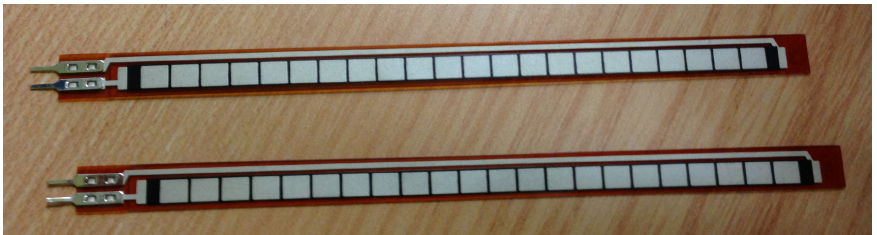
Figure 4. Flex sensor,